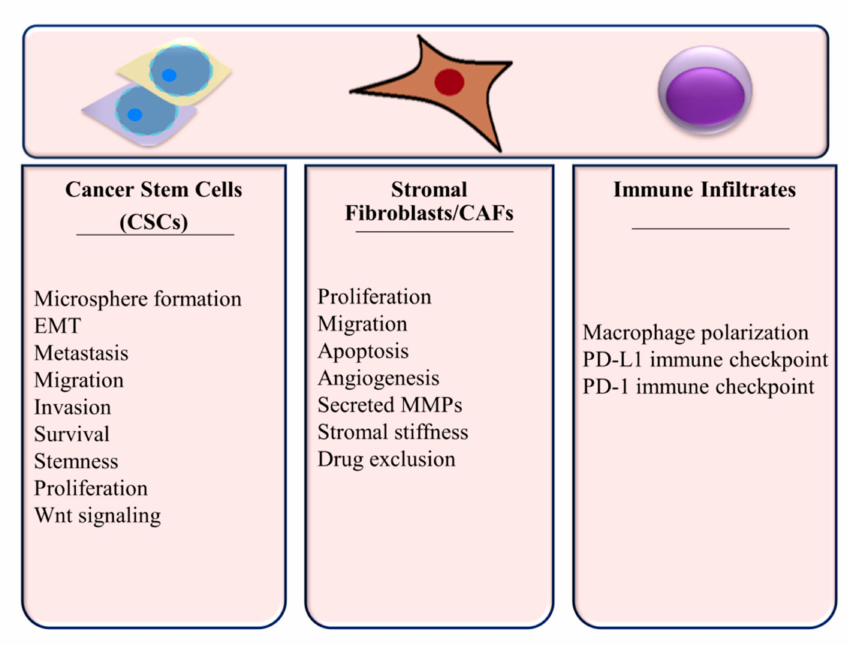
Figure 3. Cellular Processes Regulated by miRNAs in the TNBC